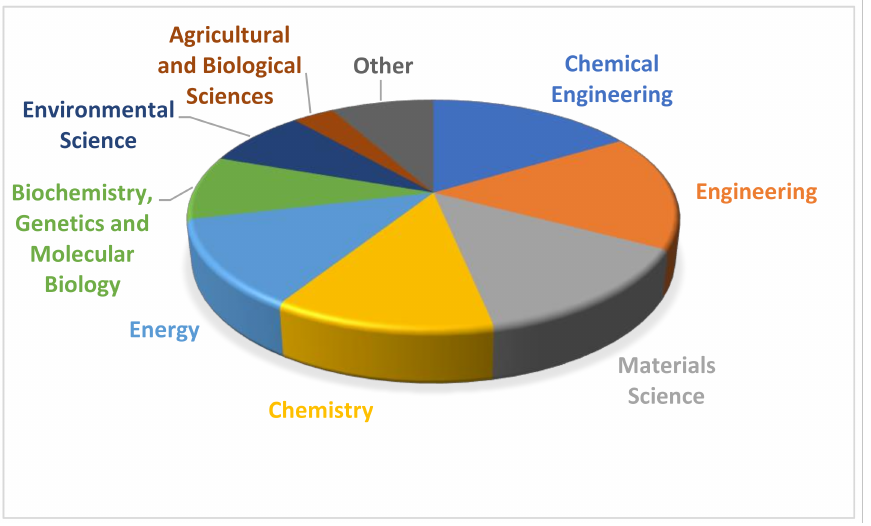
Figure 3. Areas of publication of papers dealing with polymer composites and biorefineries.